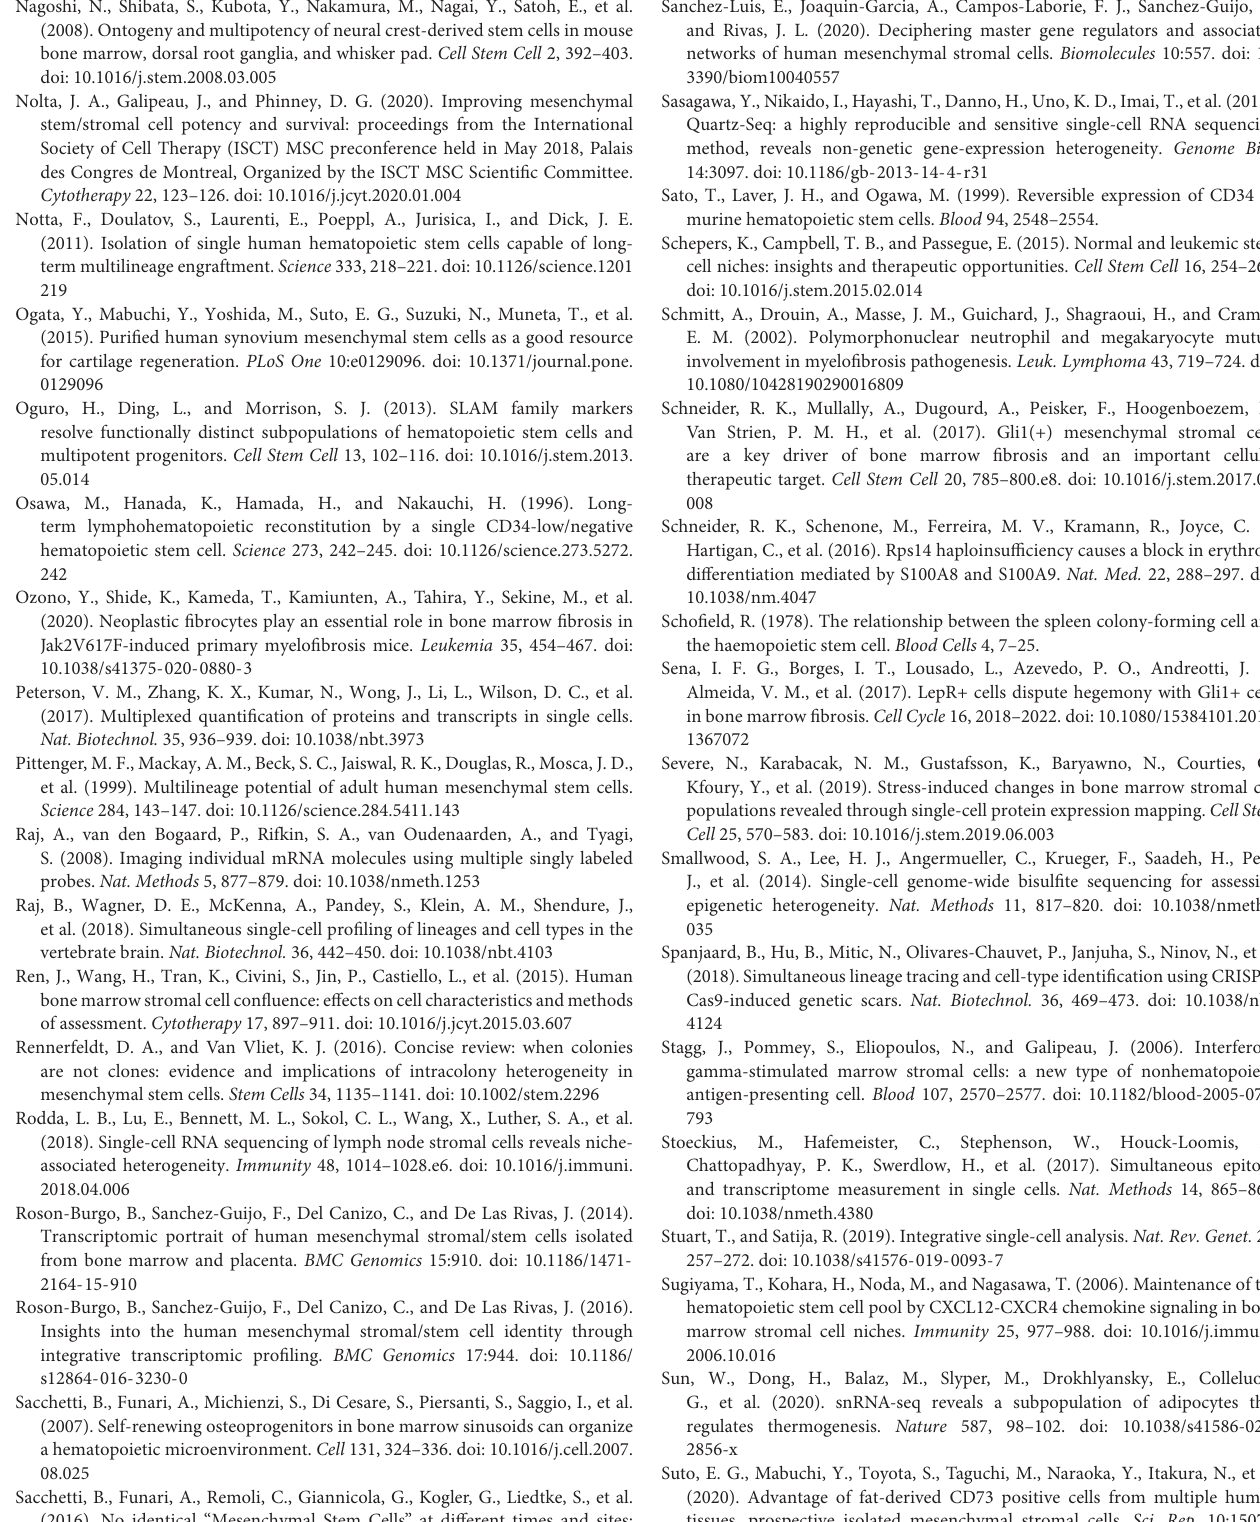
Tabarroki, A., and Tiu, R. V. (2014). Molecular genetics of myelofibrosis and its associated disease phenotypes. Transl. Med. UniSa 8, 53–64.